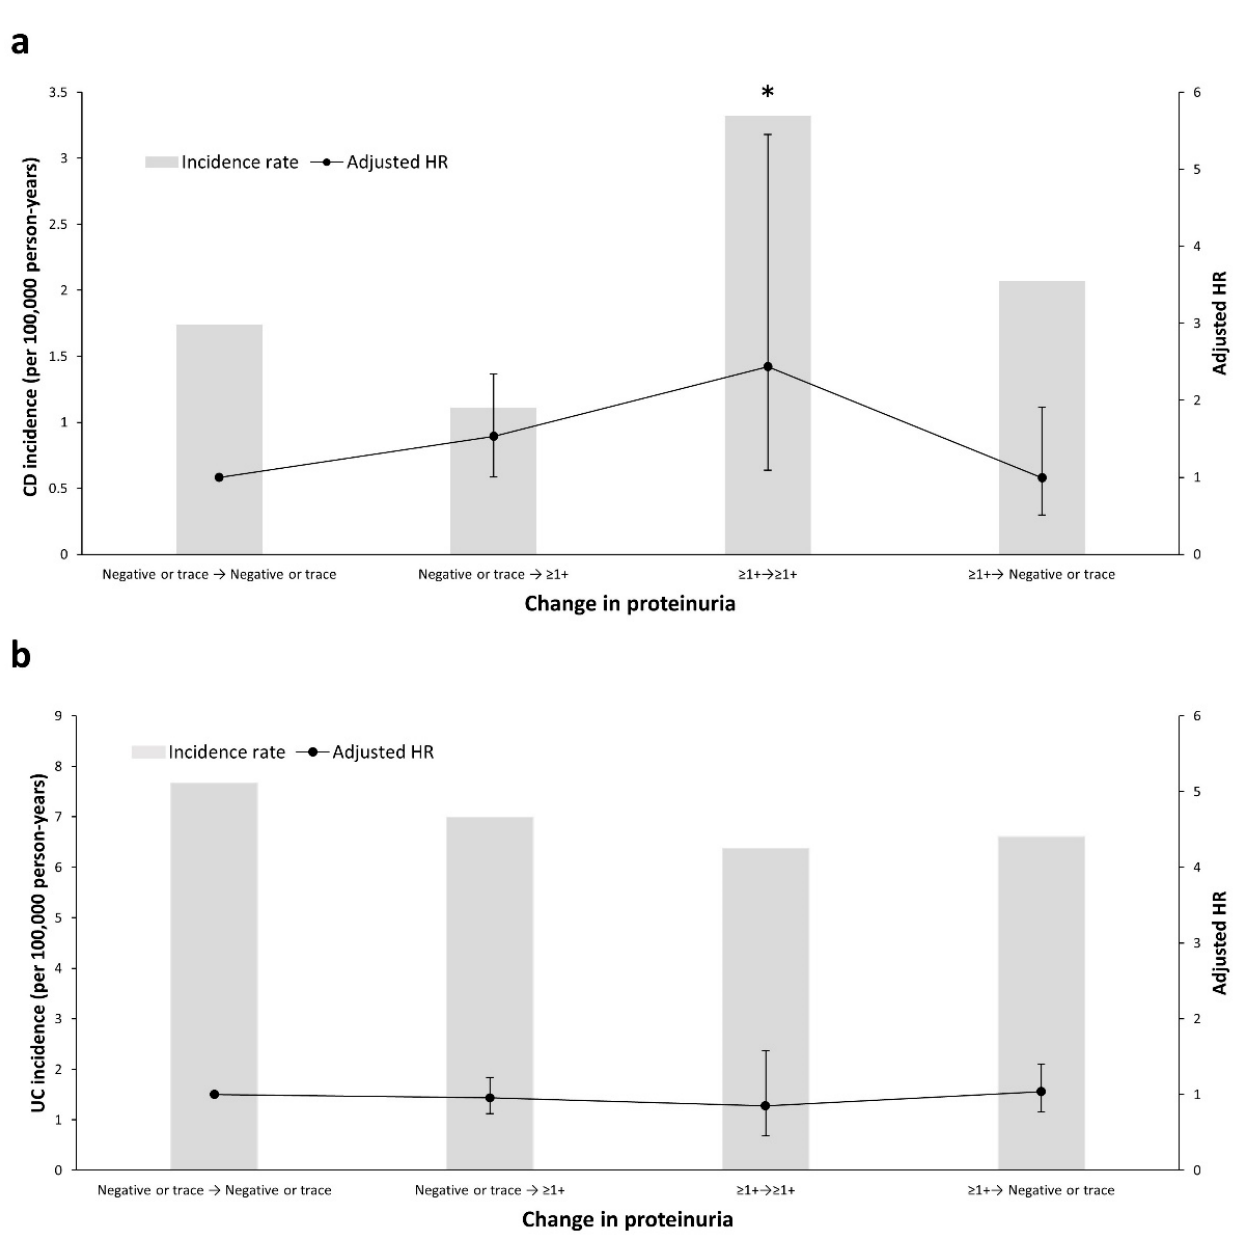
Figure 2. Incidence and risk of ( a ) Crohn’s disease and ( b ) ulcerative colitis according to changes in proteinuria measured by dipstick. Hazard ratios were adjusted for age, sex, income level, smoking status, alcohol consumption status, exercise level, body mass index, estimated glomerular filtration rate, diabetes mellitus, hypertension, and dyslipidemia. The left Y axis and columns indicate the incidence rate, the right Y axis and line indicate the adjusted HR, and the error bars indicate the 95% confidence interval. * p < 0.05. CD, Crohn’s disease; HR, hazard ratio; UC, ulcerative colitis.